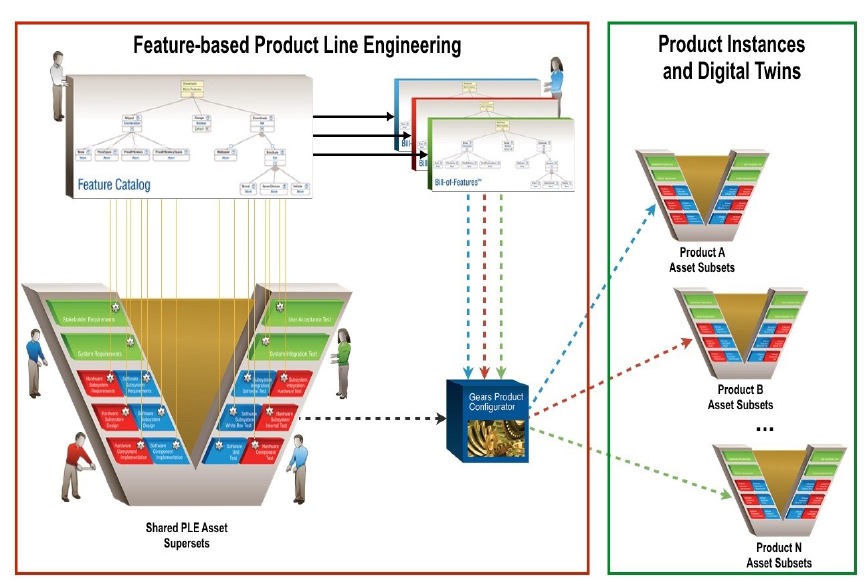
Fig. 5 – Feature Based Production Line Engineering ( illustration extracted from [ 6